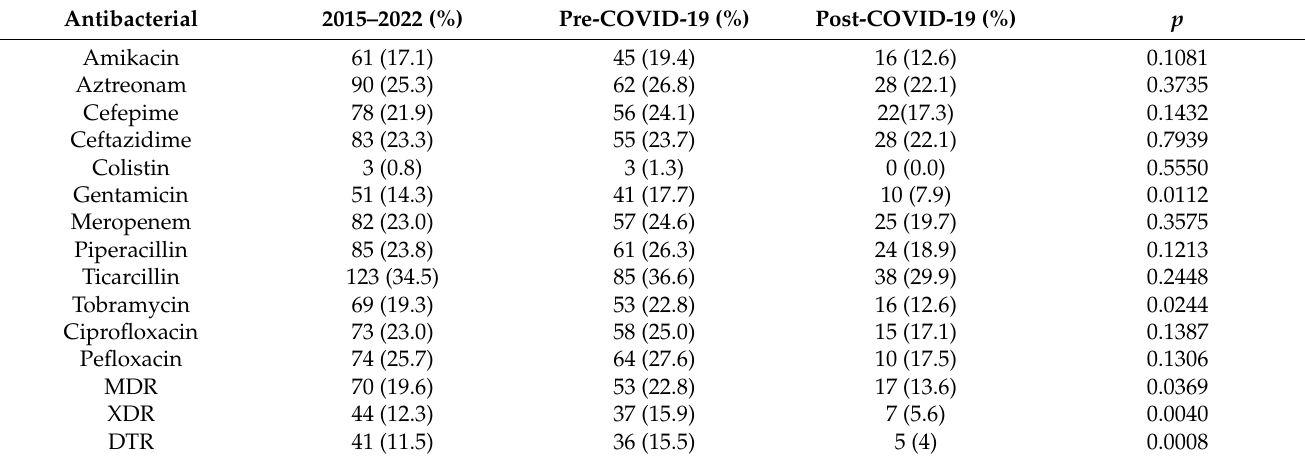
Table 4. Antimicrobial resistance of Pseudomonas aeruginosa strains isolated from patients’ blood